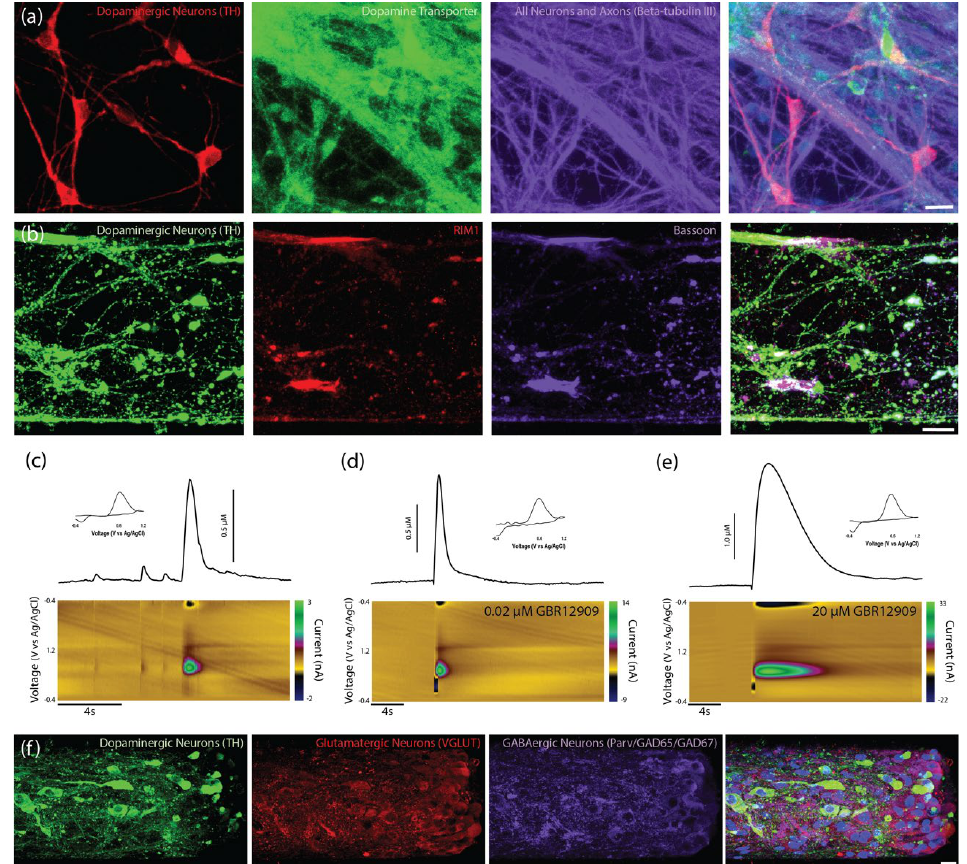
Figure 3. Characterization of unidirectional TE-NSPs. ( a ) Representative confocal reconstruction at 14 DIV of a standard midbrain population containing dopaminergic neurons labeled via immunocytochemistry to denote dopaminergic neurons/axons (TH, red), the dopamine transporter protein (dopamine transporter, green), and all neurons/axons (β -tubulin III, purple). Dopaminergic neurons exhibit expression of the dopamine transporter (DAT), a protein involved in dopamine recycling. ( b ) Representative confocal reconstruction at 14 DIV of an enriched TE-NSP labeled via immunocytochemistry to denote dopaminergic neurons/axons (TH, green), RIM proteins (RIM1, red), and bassoon proteins (Bassoon, purple). The RIM and bassoon proteins colocalize on putative dopaminergic varicosities. ( c – e ) FSCV was used to measure dopamine release from TENSPs: A stimulating electrode was positioned to span the dopaminergic aggregate while a carbon-fiber recording electrode was placed within the aggregate. Representative color plots displaying the current recorded as the potential of the carbon fiber electrode were linearly scanned fr om −0.4 to 1.2 V and back to −0.4 V vs. Ag/AgCl every 100 ms (bottom). Cross -sections from the color plots display individual cyclic voltammograms exhibiting an oxidation peak at 0.65 V and a reduction trough at −0 .3 V, which are characteristic of dopamine (inset). Representative time vs. concentration plots of evoked dopamine release (top). ( c ) Evoked dopamine release was recorded from unidirectional enriched dopaminergic neurons in TE-NSPs. ( d , e ) Evoked dopamine release was also recorded from unidirectional enriched TE-NSPs following perfusion with different concentrations of the DAT inhibitor GBR12909. The concentration of GBR12909 in ( d ) was 0.02 μ M and in ( e ) was 20 μ M. The application of the DAT inhibitor GBR12909 increased both the maximum concentration of evoked dopamine and the duration of dopamine release. ( f ) Confocal reconstructions of FACS enriched aggregates at 35 DIV labeled via immunocytochemistry to denote all dopaminergic neurons/axons (TH, green), glutamatergic neurons (VGLUT, red), and GABAergic neurons (Parvalbumin + GAD65 + GAD67, purple), with nuclear counterstain (Hoechst, blue). Following maturation over weeks in vitro, sorted aggregates demonstrated the presence of dopaminergic, GABAergic, and glutamatergic neurons. Scale bar ( a ) = 20 µm. Scale bar ( b ) = 25 µm. Scale Bar ( f ) = 20 µm.